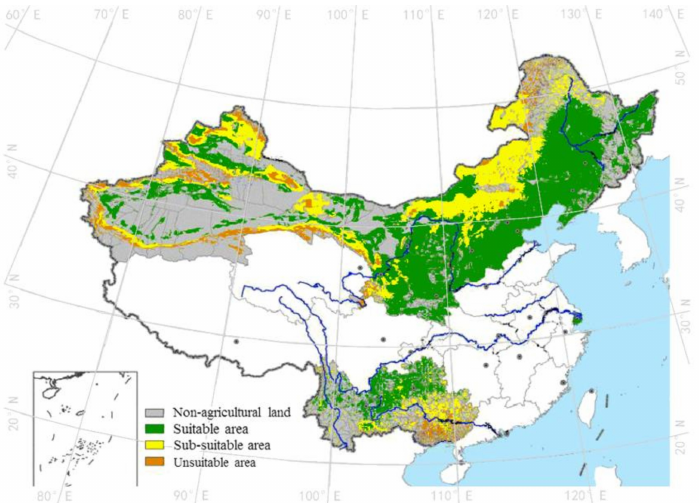
Figure 1. China’s maize planting area and suitability assessment. Source: China Meteorological